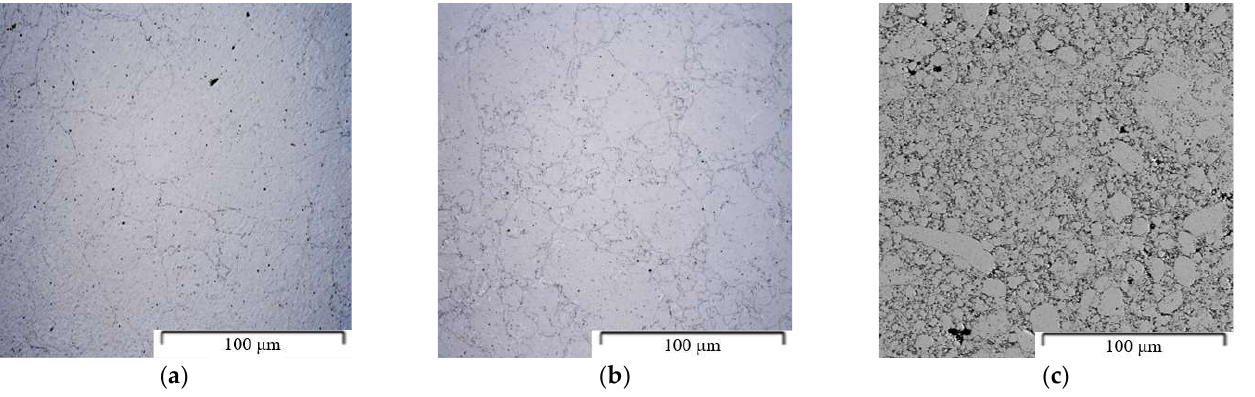
Figure 6. Materials compacted by SPS (OM): ( a ) Zn-1Mg (1200 RPM, 60 min), ( b ) Zn-6Mg (1200 RPM, 60 min), ( c ) Zn-16Mg (1200 RPM, 60 min).